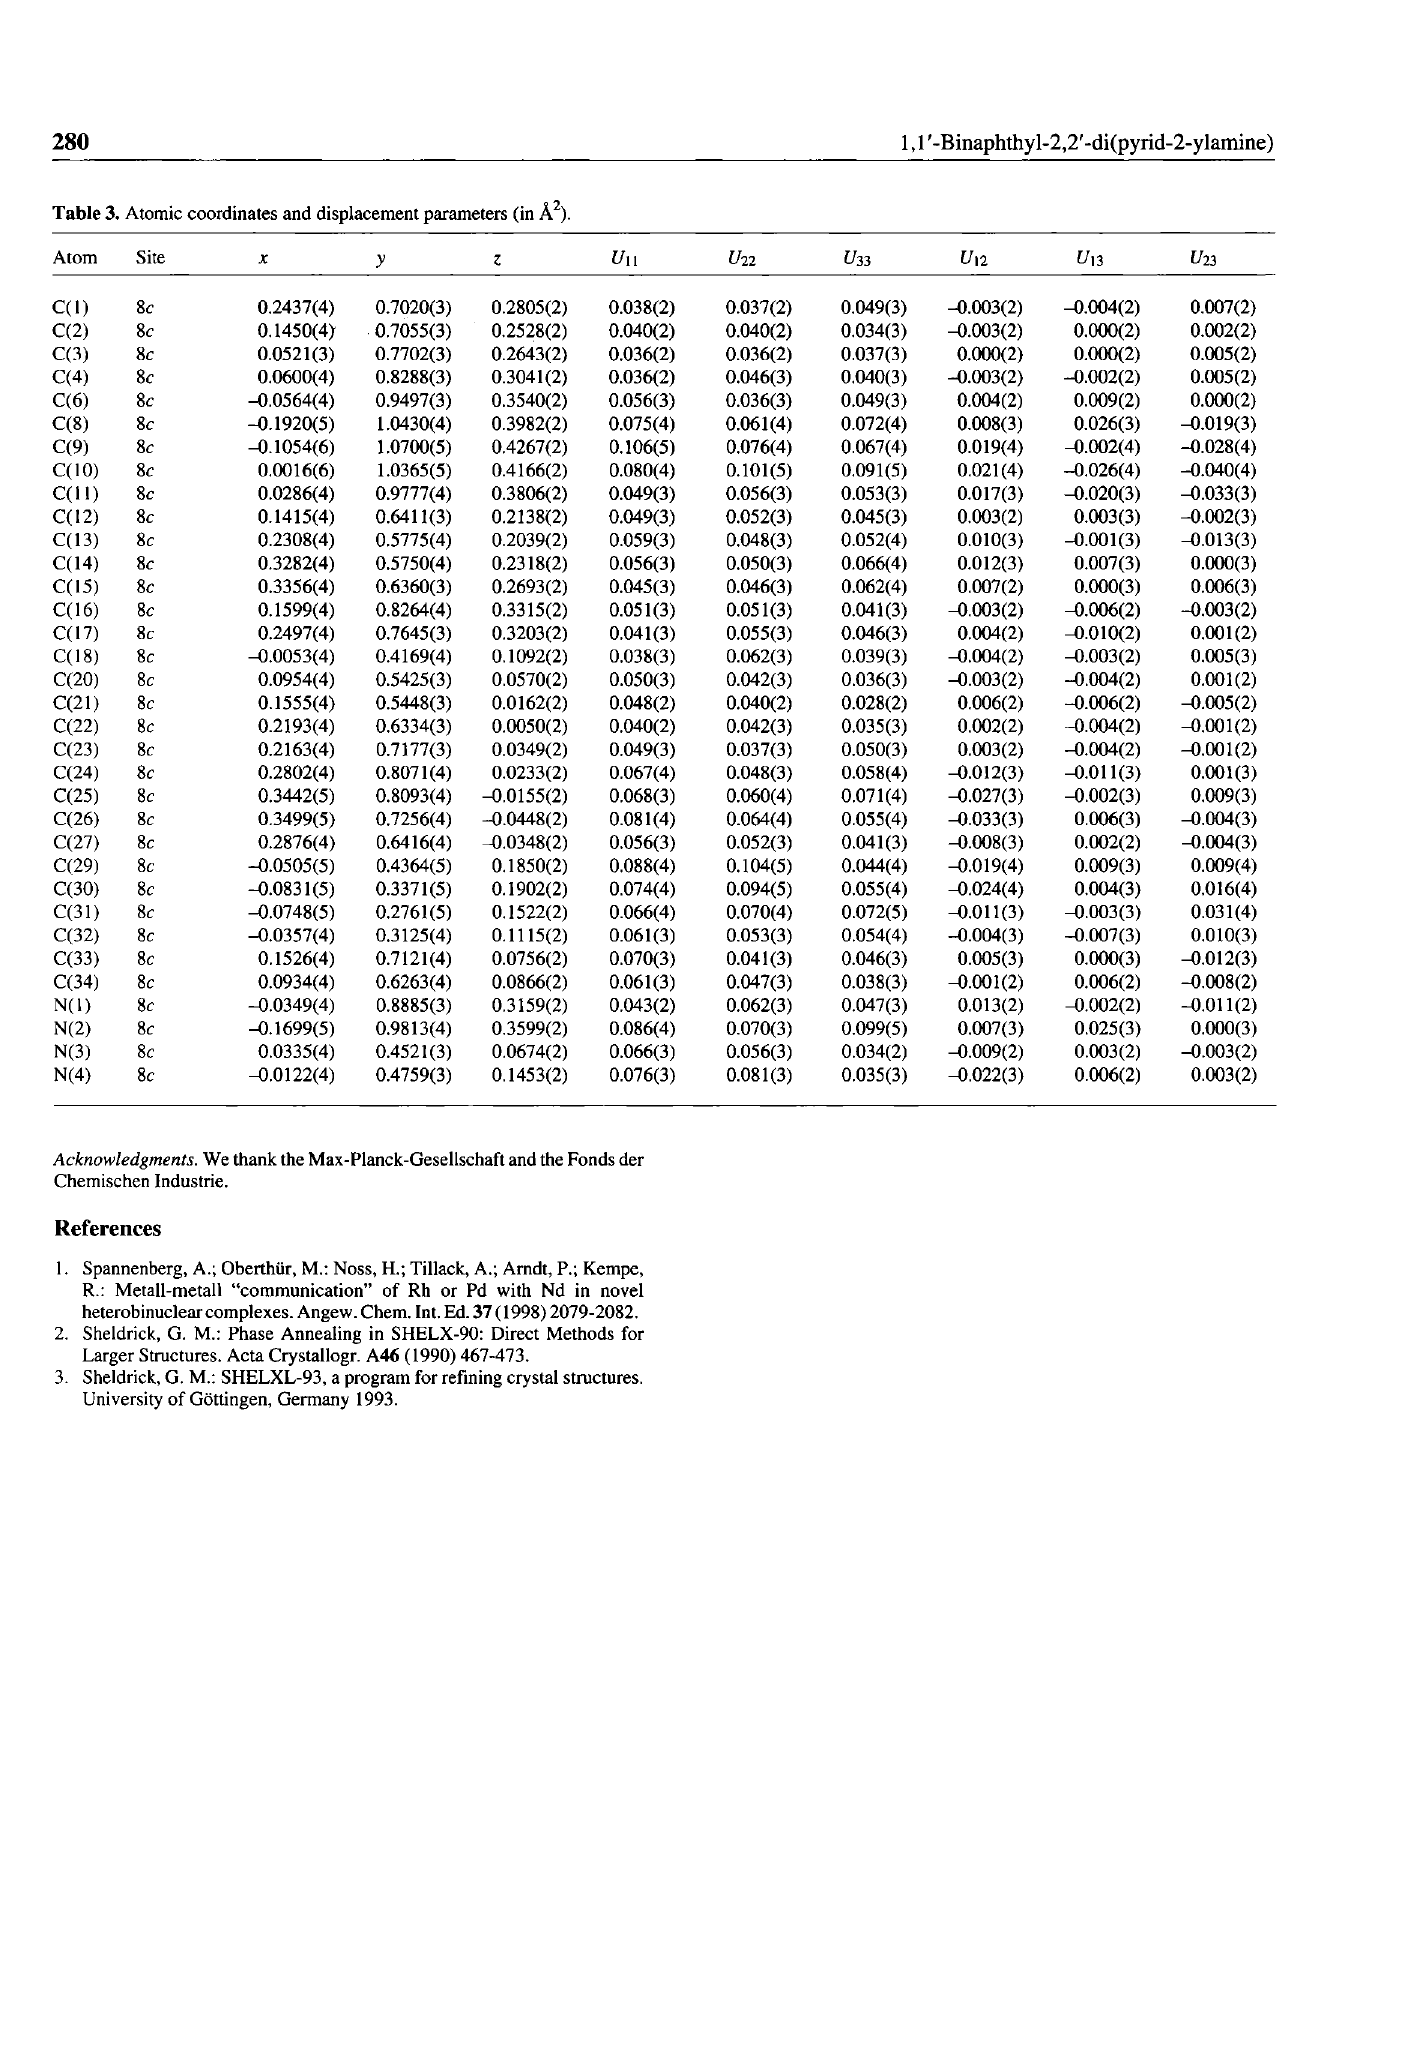
Table 3. Atomic coordinates and displacement parameters (in Ä 2 ).